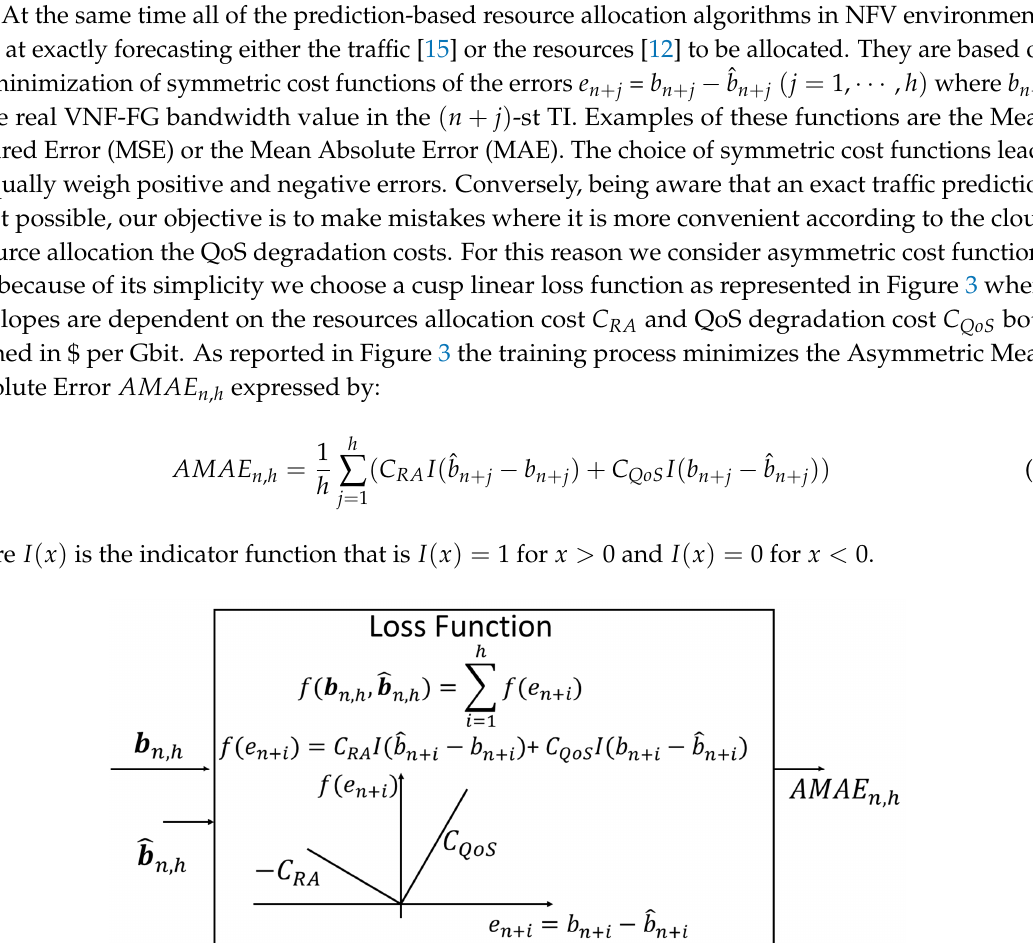
Figure 2. Long Short Term Memory (LSTM) Prediction Framework.